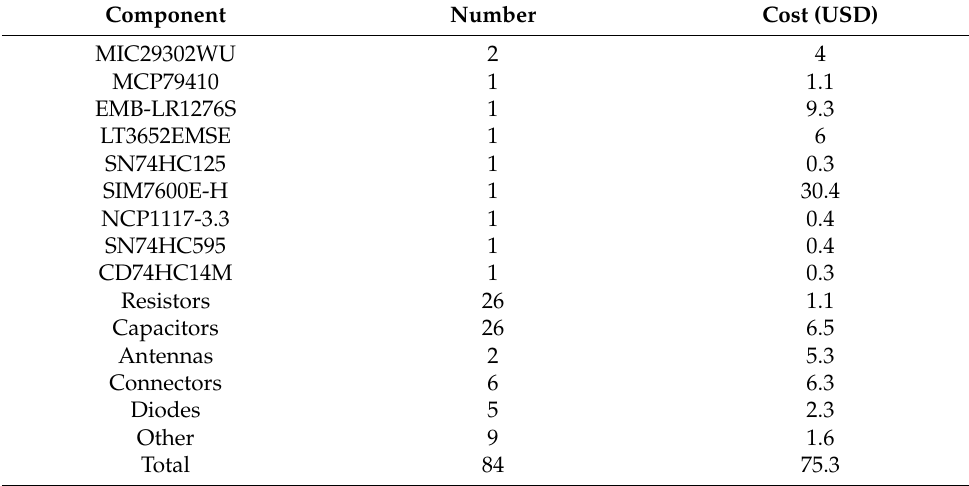
Table 2. Cost of the used electronics